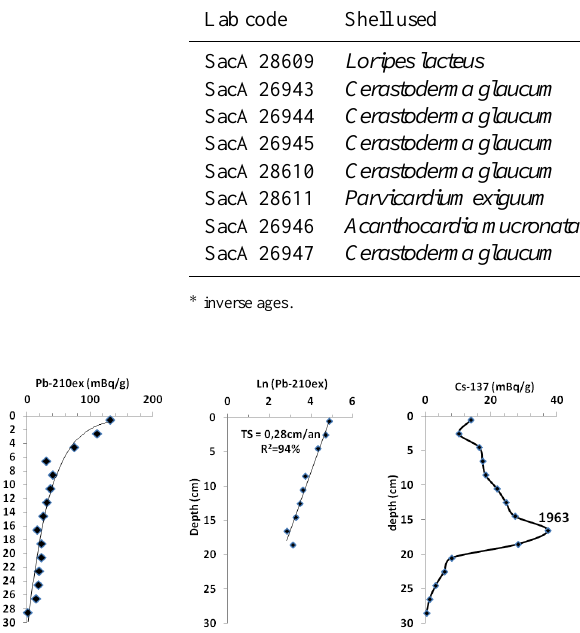
Figure 4. Profile distributions of 210 Pb ex and 137 Cs activity con- centration vs. depth in MC45 core. Using the CFCS (Constant Flux, Constant Sedimentation Rate) model, the 210 Pb data indicate a sedimentation rate of 0.28cmyear − 1 . The activity depth profile 137 Cs displays a peak at 16cm, resulting in accumulation rates of 0.3cmyear − 1 for the 1963